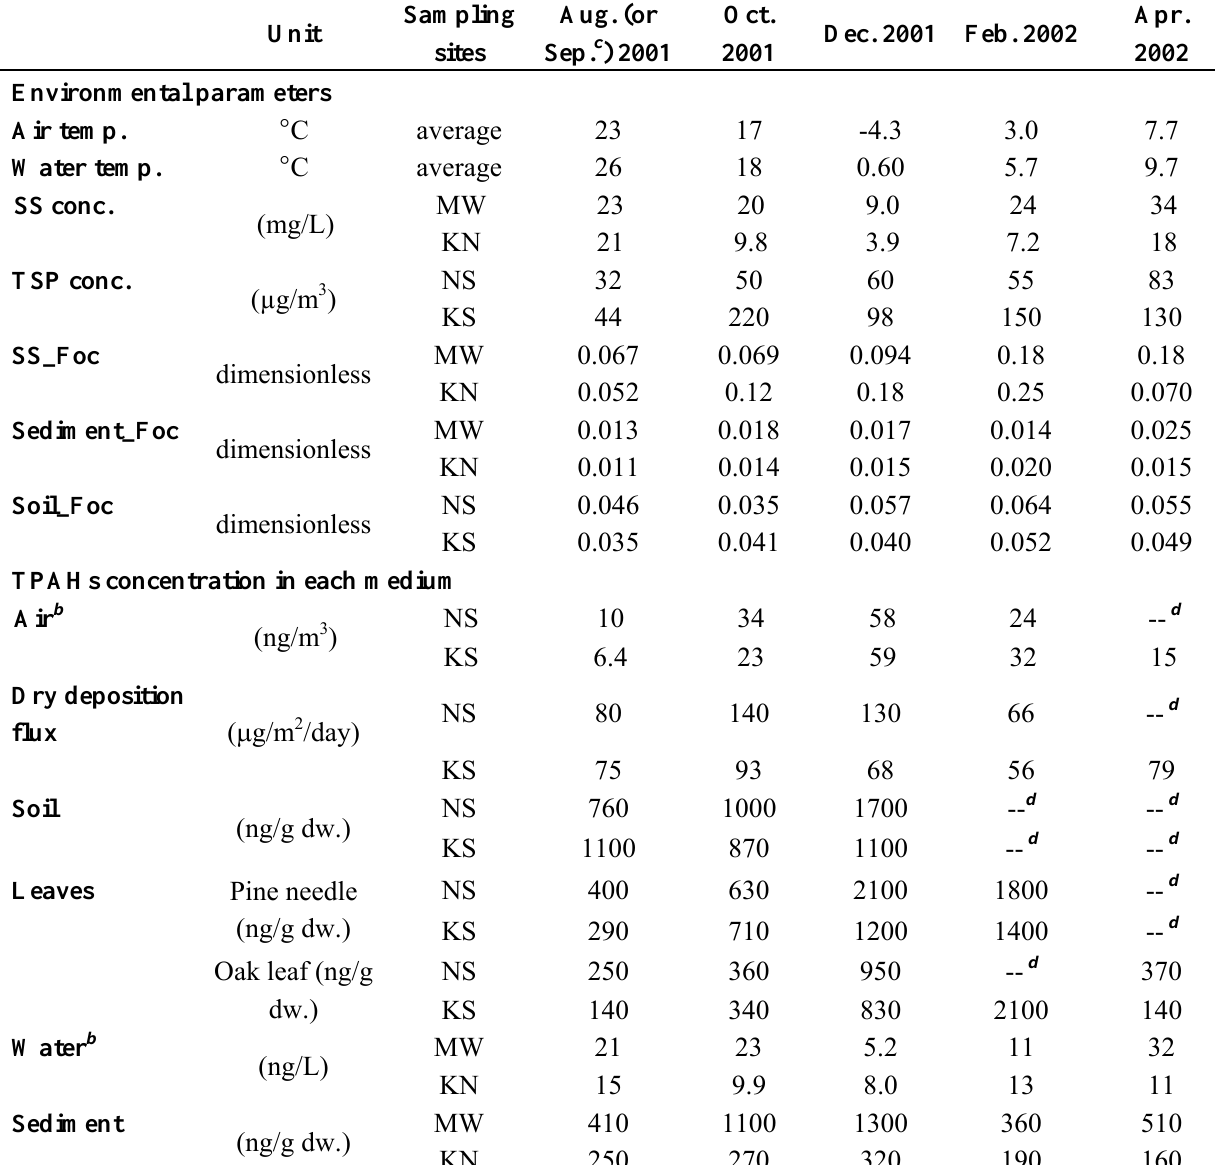
Table 1. Environmental and weather conditions during sampling and TPAHs a concentration in concurrently measured multi-media environmental